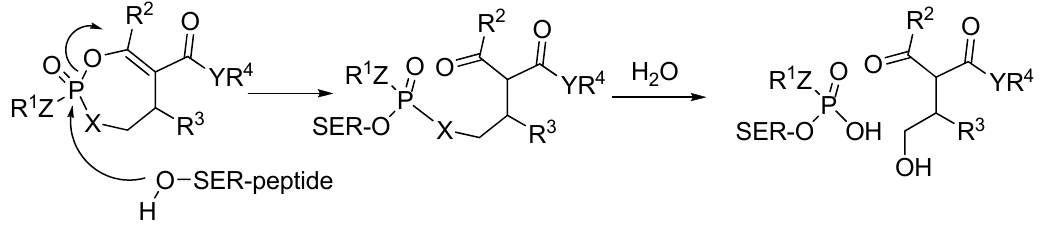
Figure 5. The proposed mode of action for cyclic enolphosphates and phosphonates.